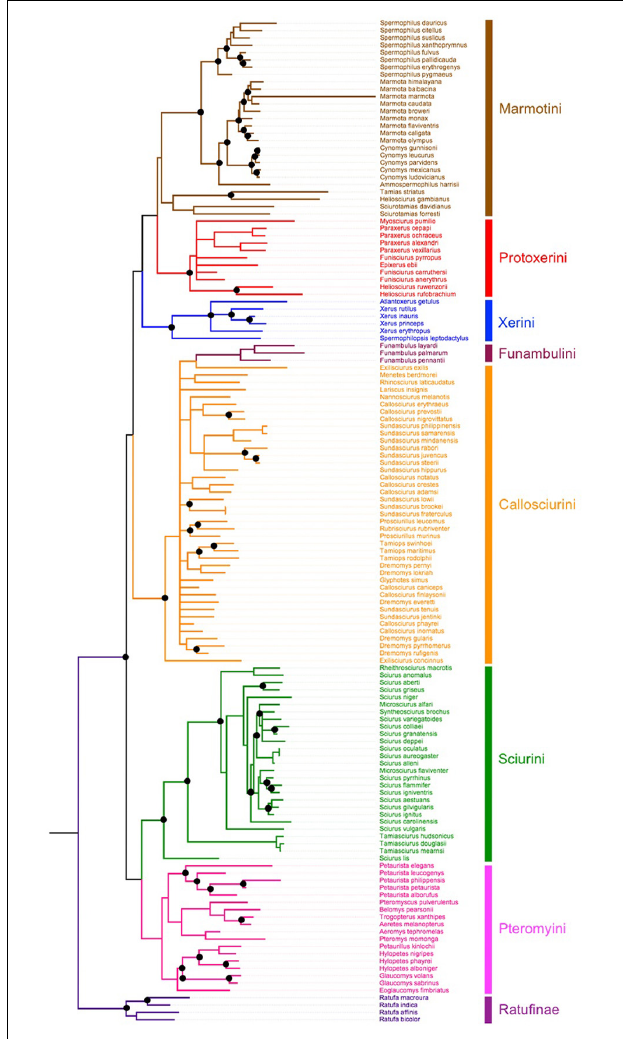
FIGURE 2 | Phylogeny representing 137 species within Sciuridae. Branch lengths are proportional to the expected number of changes per site. Dark circles represent nodes with > 95% posterior probability.